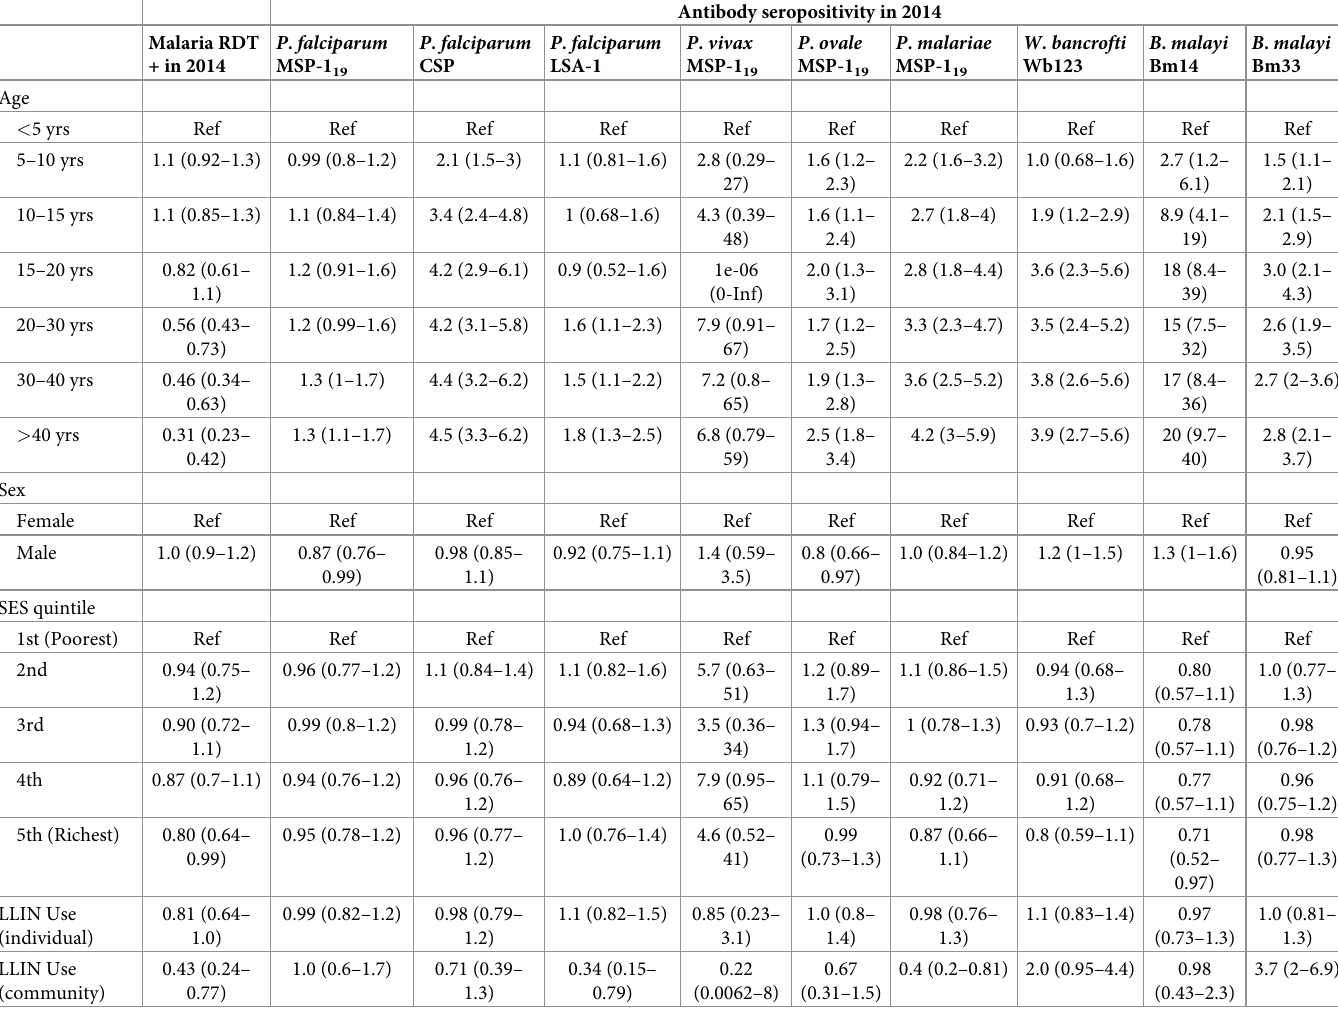
Table 5. Relative risk for malaria and lymphatic filariasis outcomes one year after an LLIN distribution campaign in Nacala-a-Velha and Mecubu´ri Districts, Mozambique, as a function of demographic, socioeconomic, and bed net usage